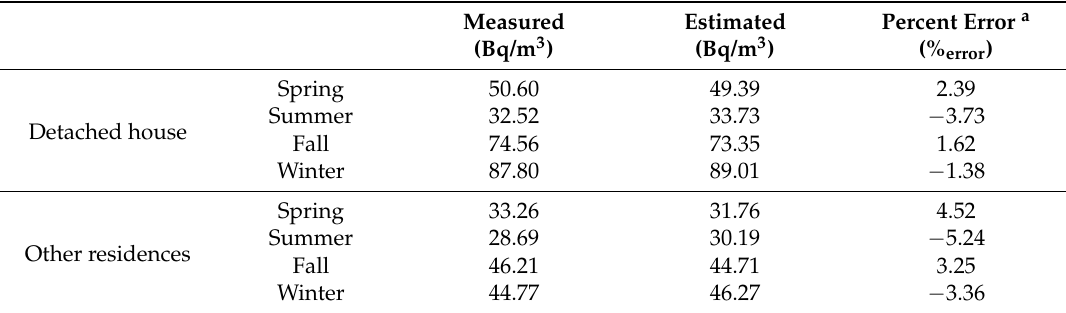
Figure 1. Monthly geometric mean of estimated indoor radon concentrations (Bq/m 3 ) calculated from Equation (5) for different types of houses. Table 3. Measured and estimated seasonal variations in indoor radon concentration calculated from Equation (5) for different types of houses.